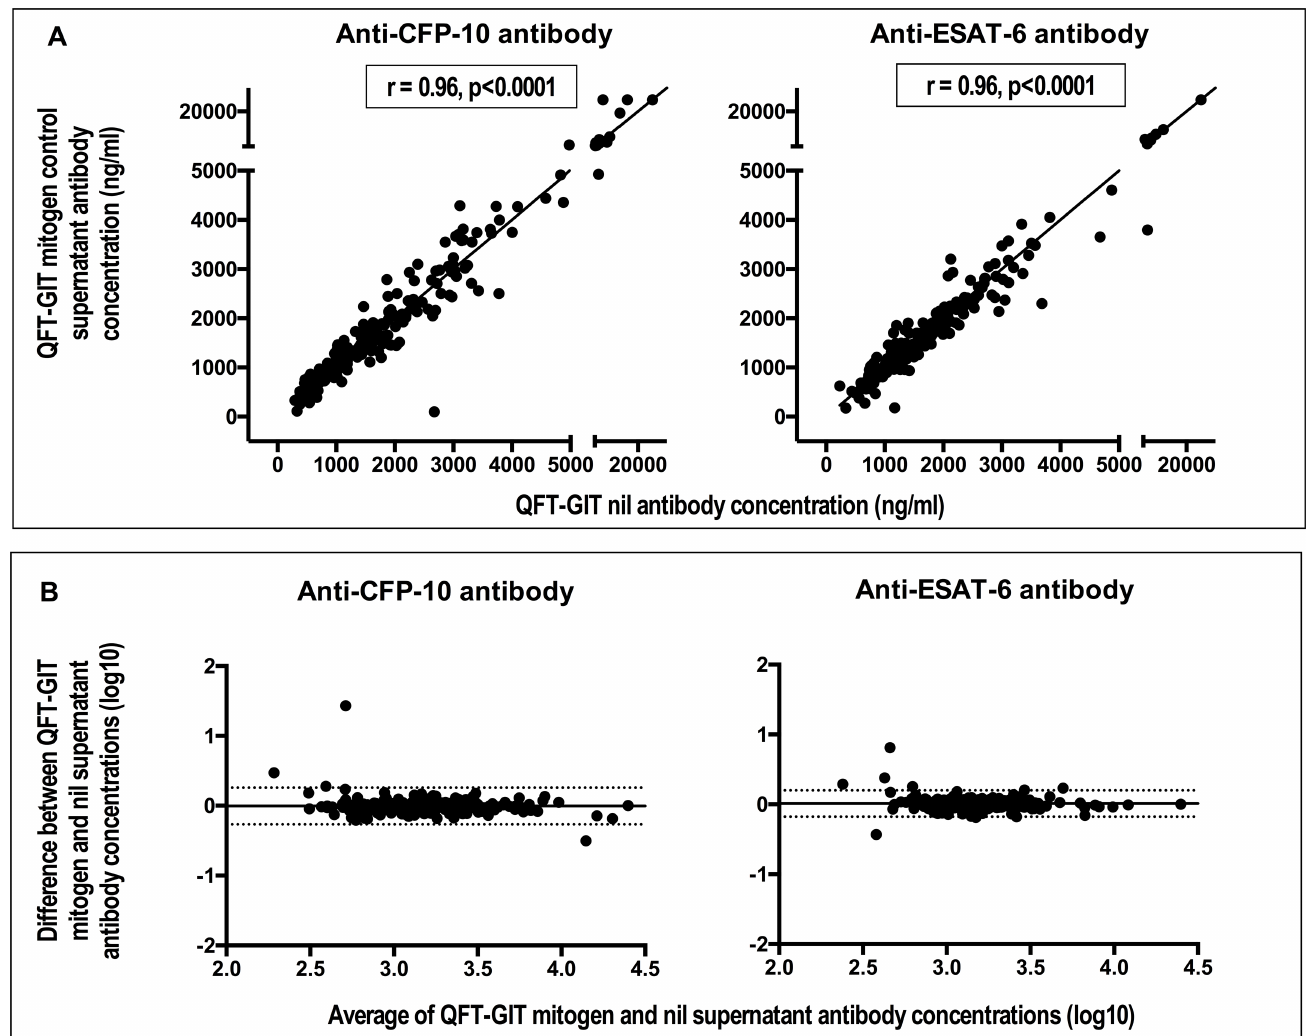
Fig 2. Anti-CFP (culture filtrate protein)-10 & anti-ESAT (early secretoryantigenic target)-6 antibody concentrations in QFT-GIT mitogen control supernatants strongly correlate with those in QFT-GIT nil control supernatants and there are no statistical differences between them. Panel A: scatter plots showingcorrelation.The coefficient (r) and the p values shown correspond to results from Spearman’s rank correlation. The solid lines are lines of identity. Panel B: Bland Altman plots showingagreement. The solid horizontal line represents the bias or averagedifference whilethe dotted horizontal lines are 95%